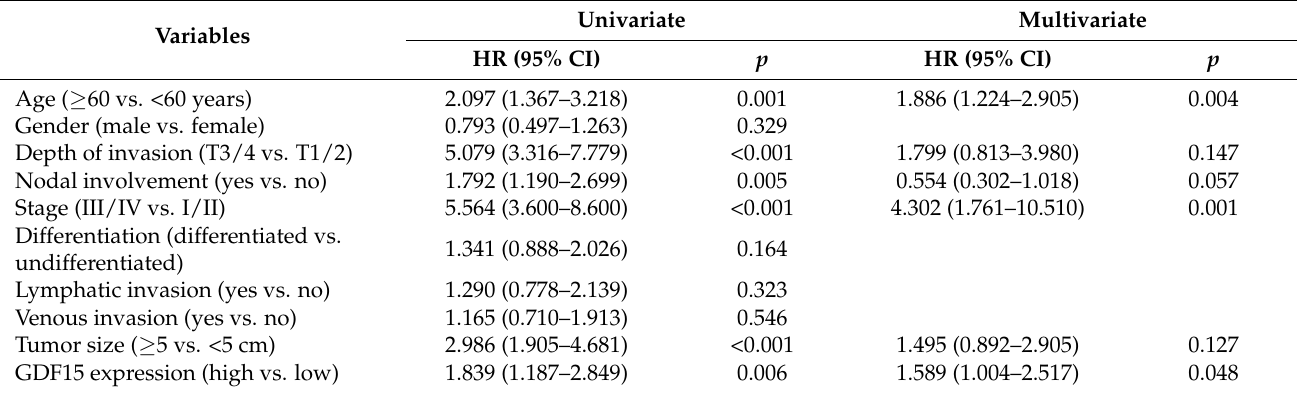
Table 2. Univariate and multivariate analyses of the clinicopathological parameters and GDF15 expression in patients with gastric